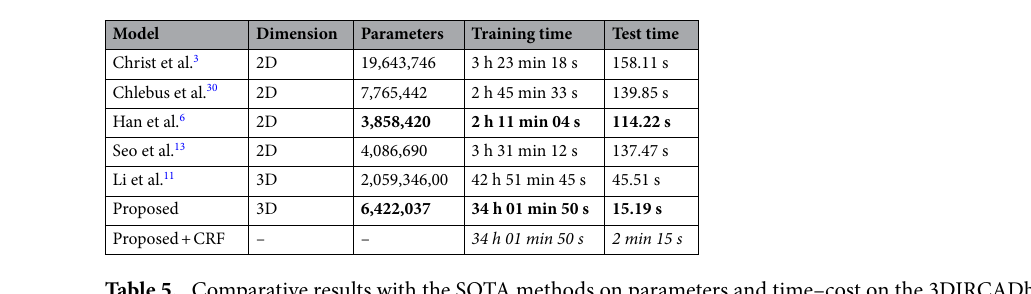
Table 5. Comparative results with the SOTA methods on parameters and time–cost on the 3DIRCADb dataset. Significant values are in bold and italics.